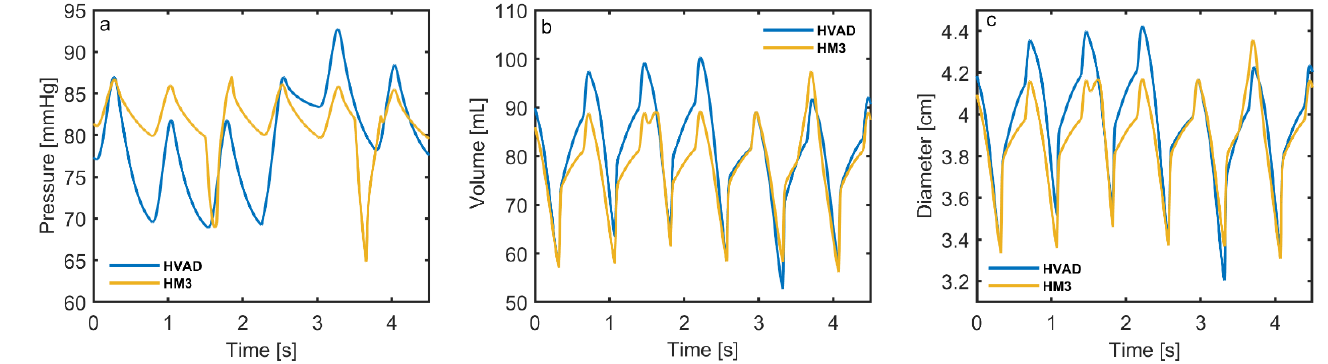
Figure 4. ( a ) Aortic pressure, ( b ) left-ventricular volume, ( c ) left-ventricular diameter under HVAD, and HM3 support during Lavare cycle and artificial pulse.